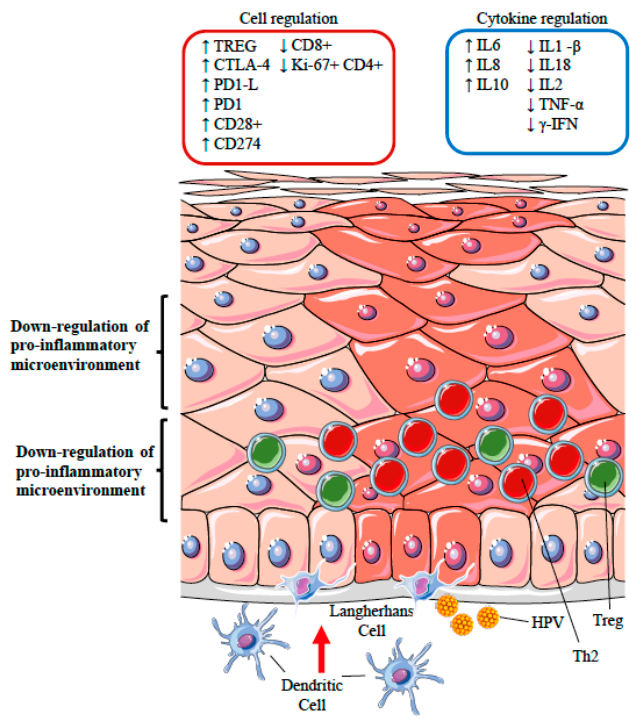
Figure 2. Schematic representation of the HPV strategies likely to modify the immunological microenvironment in the site of